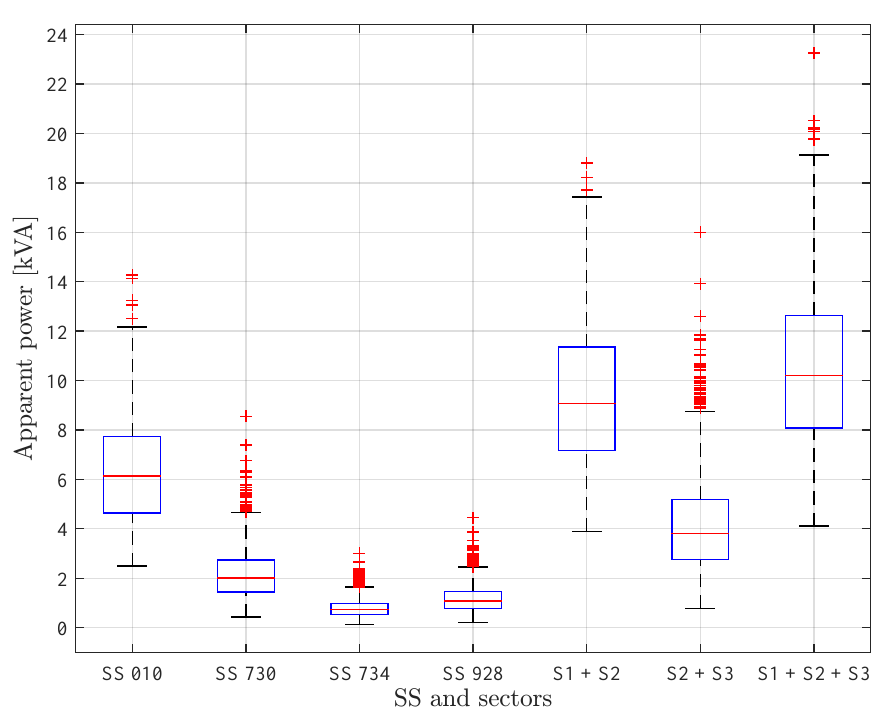
Figure 19. Statistic analysis of power demand profiles in the PN through box plots. For the sake of clarity, the red central mark indicates the median, and the bottom and top edges of the blue box indicate the 25th and 75th percentiles, respectively. The whiskers extend to the most extreme data points not considered outliers, and the outliers are plotted individually using the red “+”